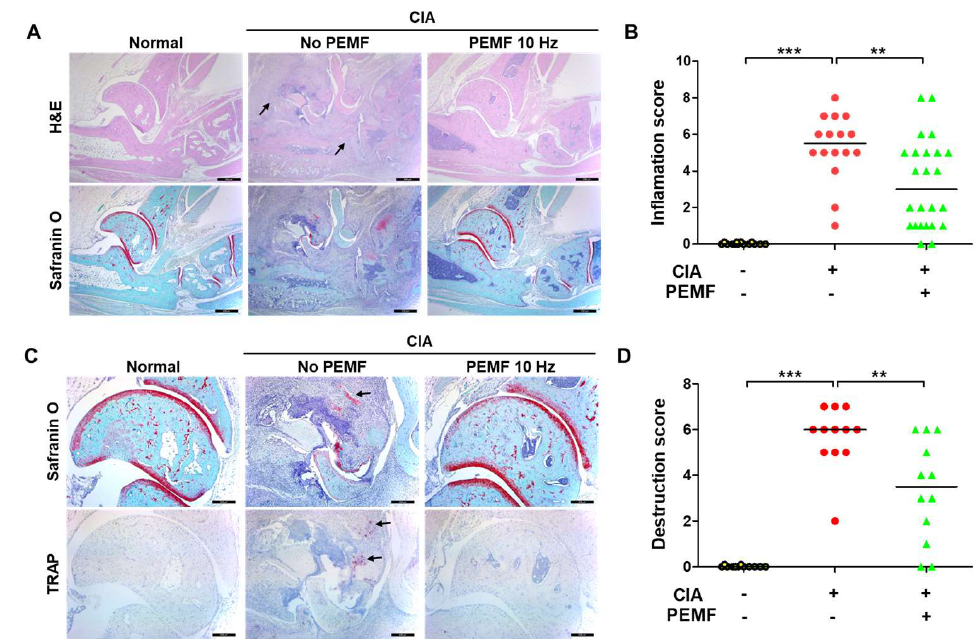
Figure 2. Effects of PEMF (10 Hz) on joint inflammation and cartilage destruction. ( A ) H&E (upper panel) and safranin O (lower panel) stained images of hind paw tissues. The magnification is × 40. Bar, 500 μm. Inflammatory cell infiltration is indicated by black arrows. ( B ) Inflammation scoring of H&E stained tissue. ( C ) Representative safranin O (upper panel) and tartrate-resistant acid phosphatase (TRAP; lower panel) stained images of hind paw tissues. The magnification is × 100. Bar, 200 µ m. Cartilage destruction is indicated by black arrows. ( D ) Histopathological scoring of safranin O stained tissue based on the destruction of cartilage and bone. Significance was measured using a two-tailed Student’s t -test (** p < 0.01 and *** p < 0.001). Bars indicate the median. Each dot represents one mouse.